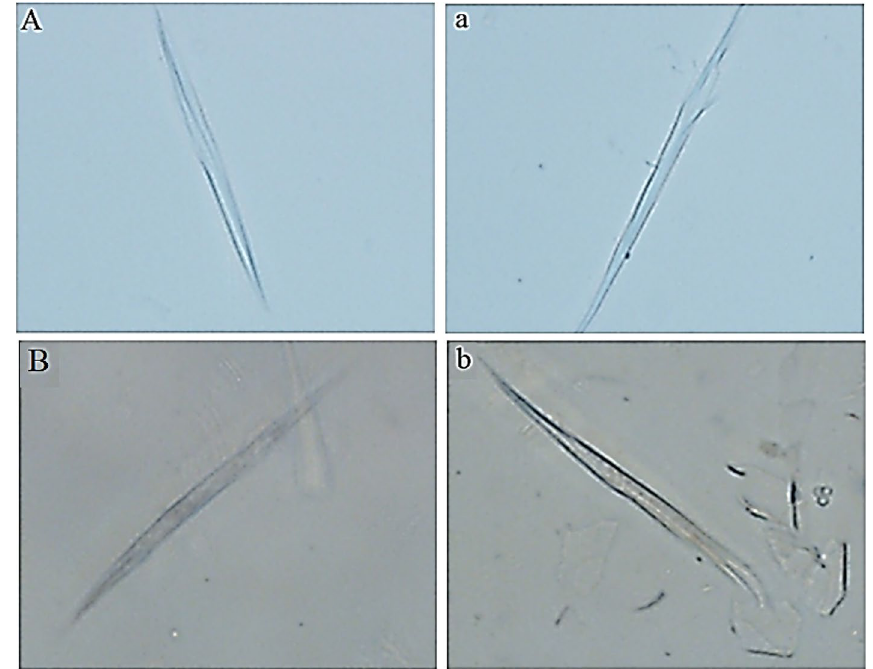
Figure 5. The cortical cells at (400x) magnification for ( A ) Inner Mongolia Cashmere goat, ( B ) Dazu black goat. The stromal cells at (400×) magnification for ( a ) Inner Mongolia Cashmere goat, ( b ) Dazu Black